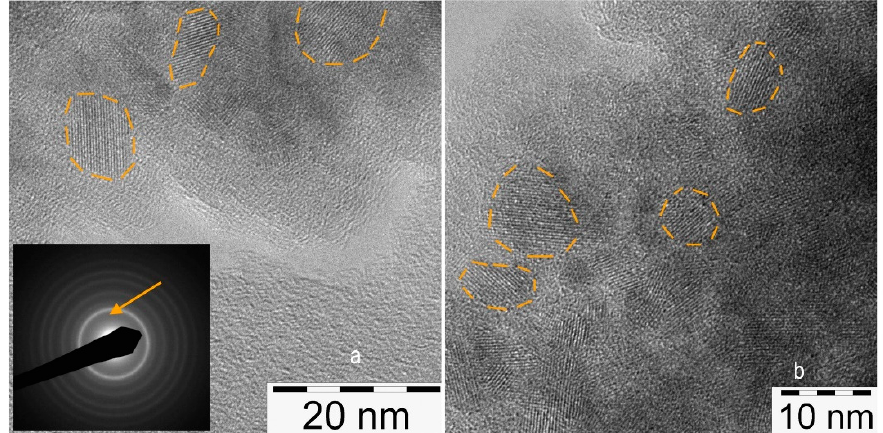
Figure 7. Bright-field TEM images of nanometric anatase with scale bar 20 nm ( a ) and 10 nm ( b ). The inset in Figure 7a shows a representative SAED pattern with ring shaped diffraction effects, due to randomly oriented nanocrystals. The orange arrows point the 3.5 Å (101) reflection. Orange dashed lines in both images highlight single-crystal anatase, in variable orientation.